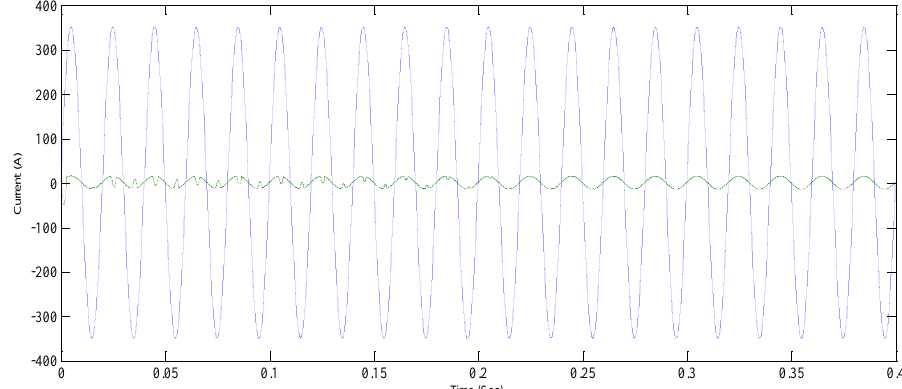
Figure 25. Current output of qZS-CHBMLI.